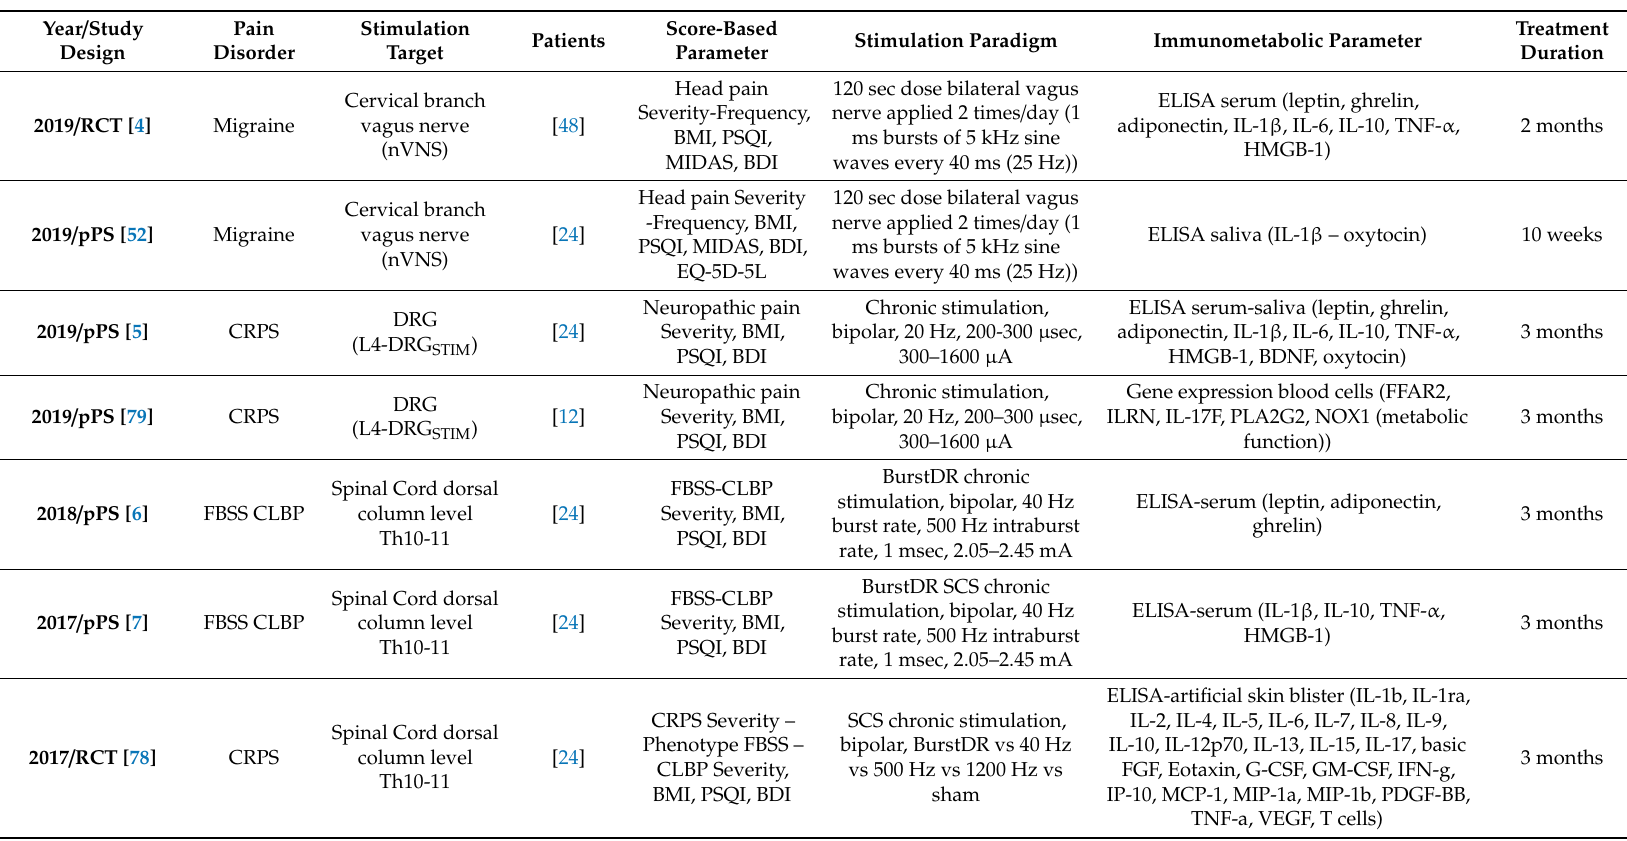
Table 1. In-human neurostimulation trials for chronic pain disorders addressed to molecular phenotyping, including markers relevant for